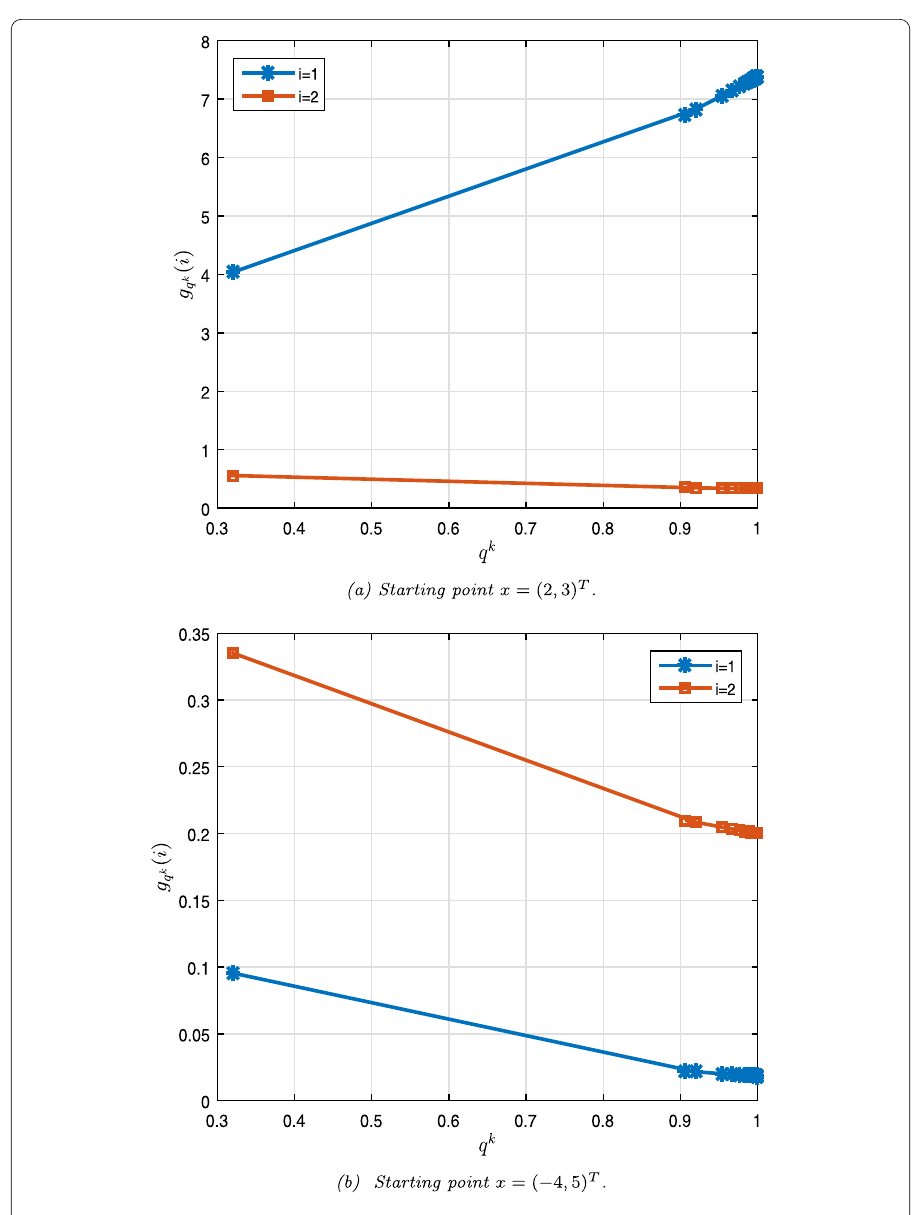
Figure 1 Graphical representation of q -gradient of Tables 1 and 2